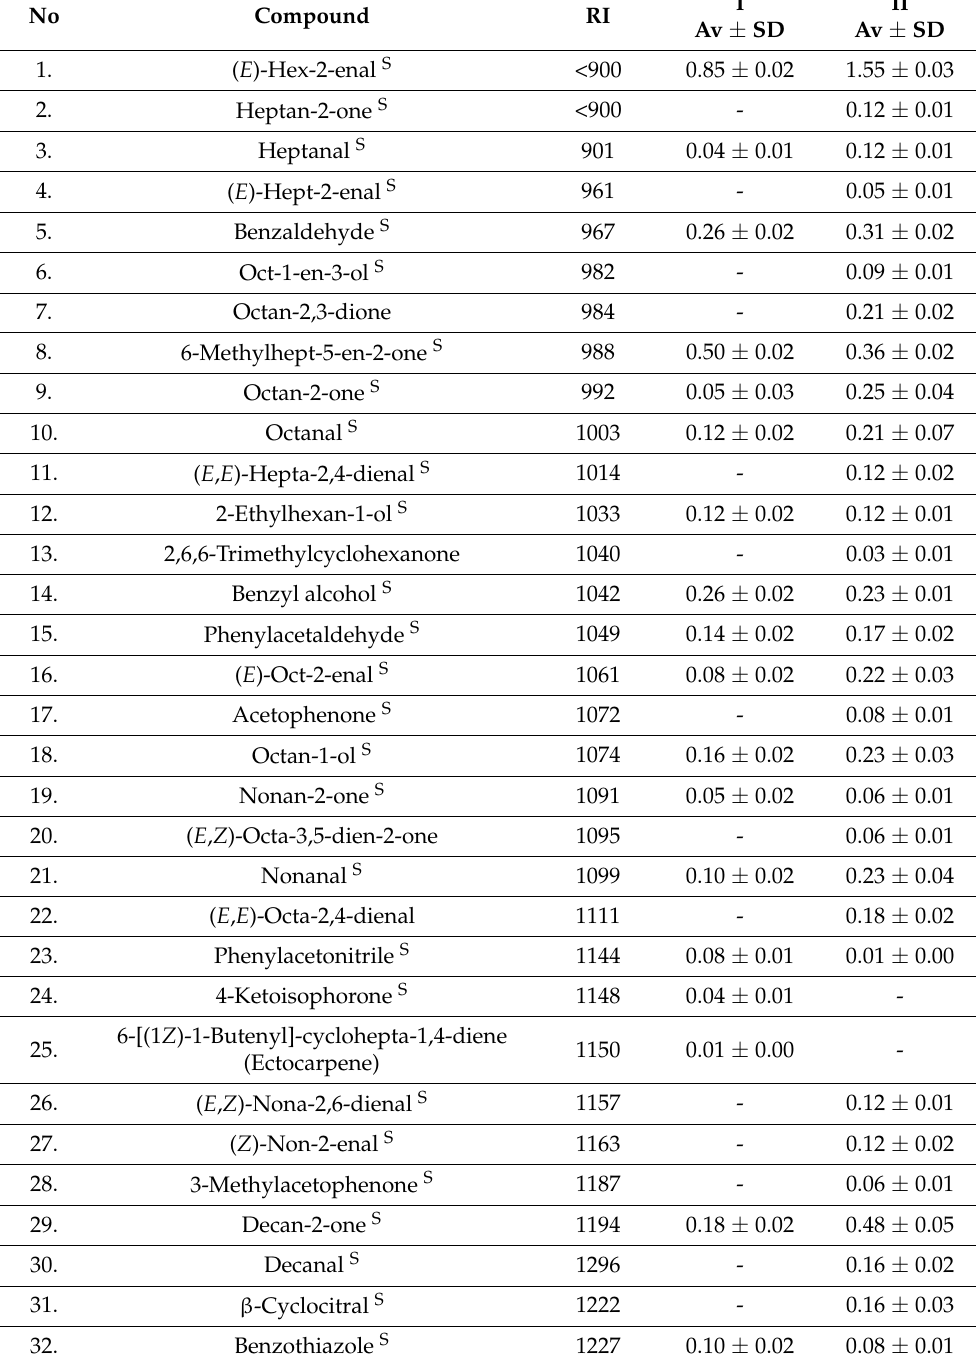
Table 2. The volatile oil compositions of A. rigida determined by HD/GC–MS (I—volatile oil compo- sition from fresh sample and II—volatile oil composition from air-dried